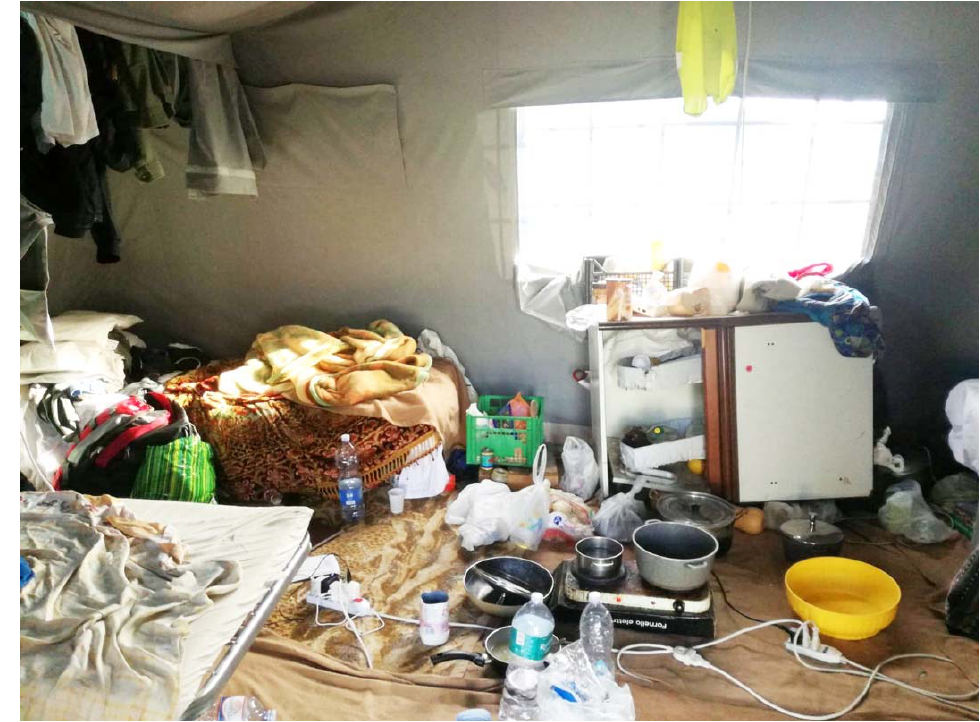
Figure 3. The interior of a shared tent in the San Ferdinando settlement.